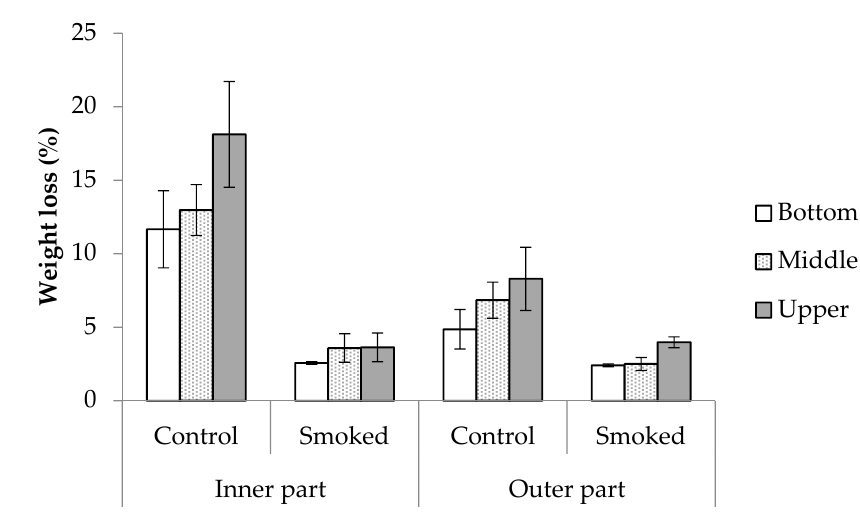
Figure 7. Wood weight loss after 10 weeks exposed to decay fungus.